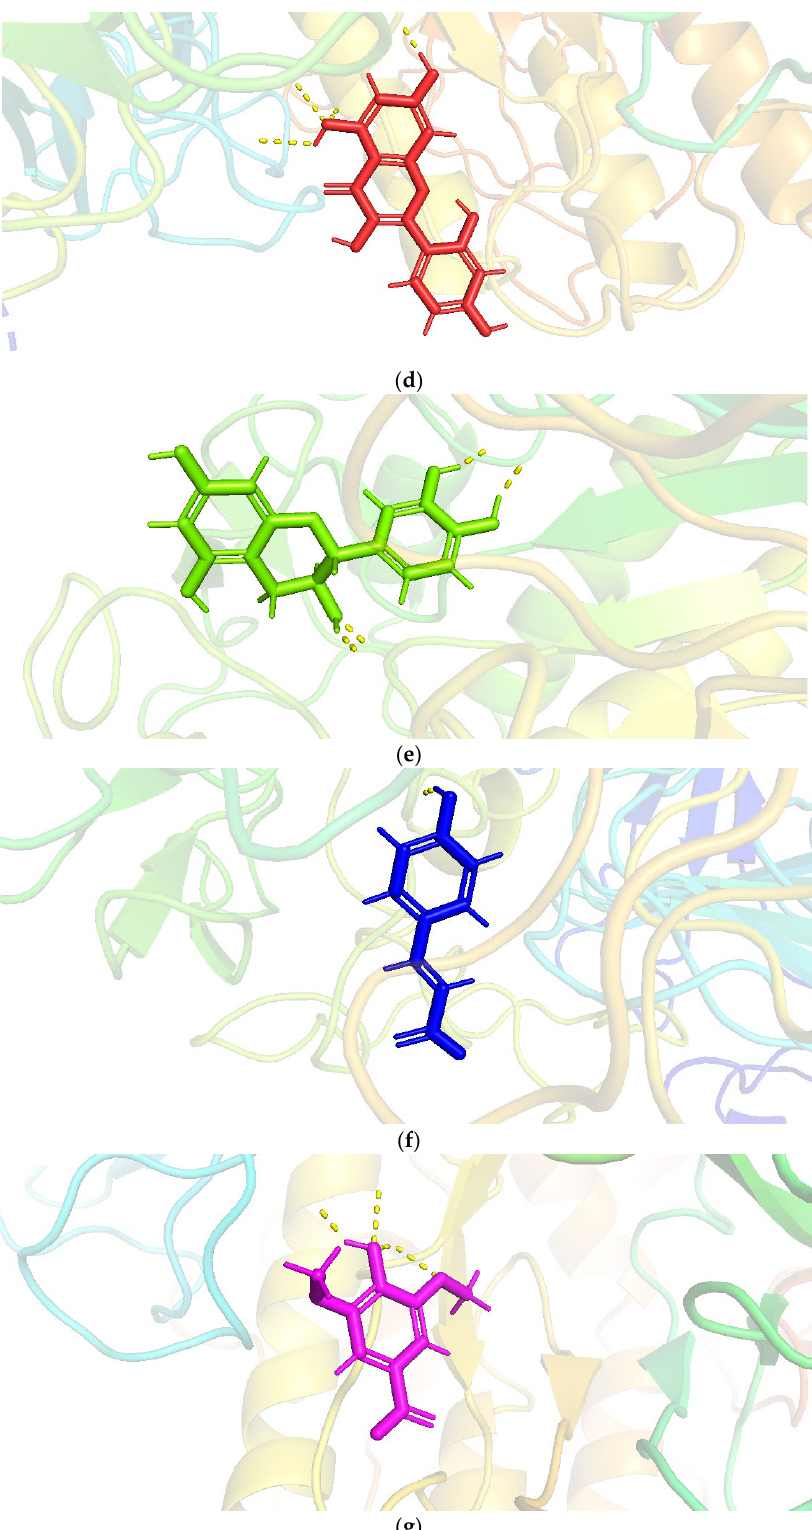
Figure 2. Molecular docking of polyphenolic compounds of Tradescantia pallida with human α - glucosidase protein 5NN5: ( a ) hen-shaped protein 5NN5 docked with ligands, ( b ) 1-DNJ, ( c ) standard, ( d ) FTP1, ( e ) FTP2, ( f ) FTP3, and ( g ) FTP4; 1-DNJ is 1-deoxynojirimycin, standard is acarbose, FTP1 is morin, FTP2 is catechin, FTP3 is p -coumaric acid, and FTP4 is syringic